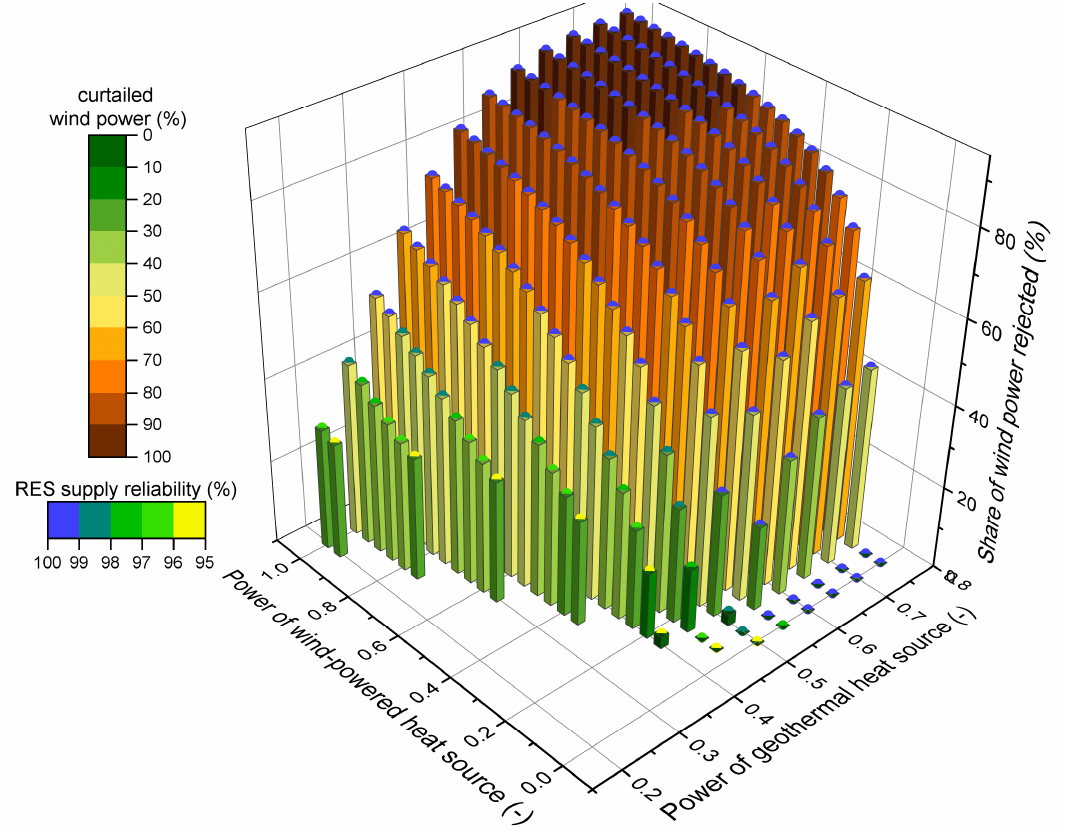
Figure 2. Curtailed wind power and reliability of energy supply from renewable energy sources for various system configurations for a typical meteorological year. The heat storage capacity is equal to the energy needed to satisfy the energy demand for 96 hours of nominal district heating (DH) operation.